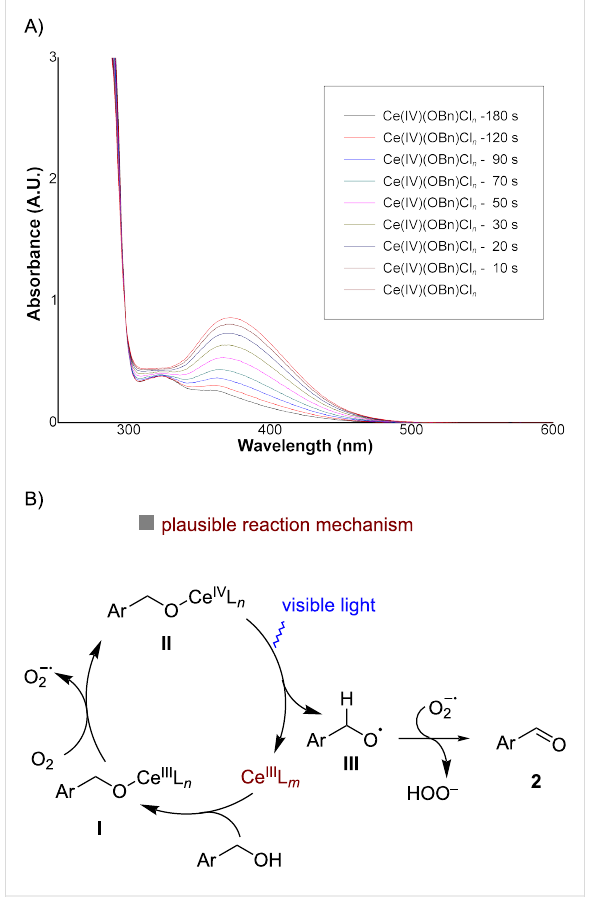
Figure 1: Mechanistic studies. (A): UV–vis spectra of the Ce IV (OBn)Cl n complex in CH 3 CN under blue light irradiation (0–180 s); (B): plausible reaction